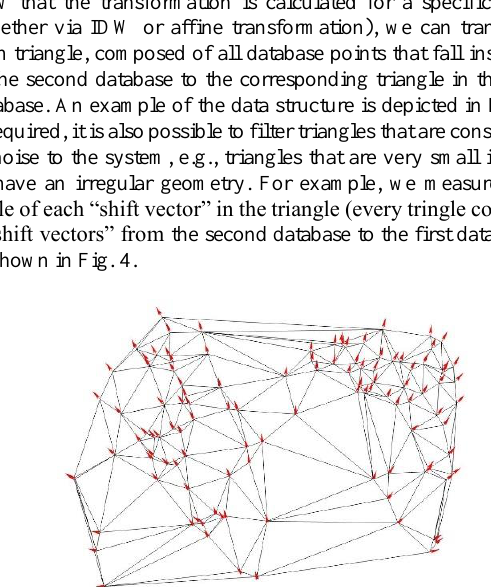
Figure 4. Delaunay triangulation based on homological